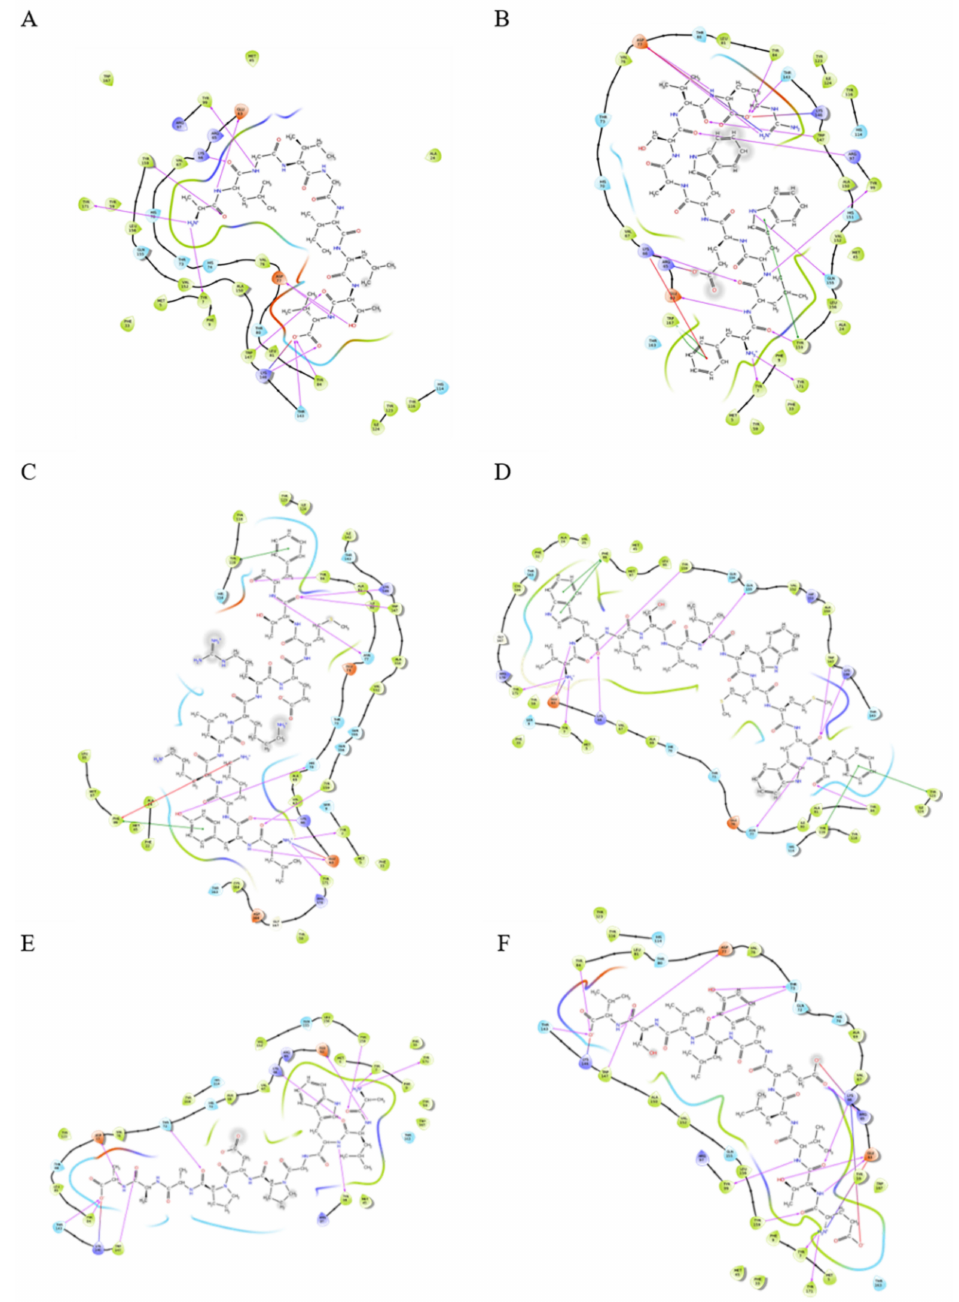
Figure 2. A 2D structure of the interaction between peptide and HLA structure. Residues are represented by the shape of water droplets. The interactions between residues and ligands are represented by lines and colored according to different interaction types. The hydrogen bond is colored in magenta and the Pi-Pi bond is colored in green. Magenta gradient lines represent salt bridge. ( A ) Interaction of HLA-A * 02:01 (PDB ID: 1JHT) and its peptide (ALGIGILTV). Hydrogen bonds are formed between peptide and amino acids TYR7, GLU63, LYS66, ASP77, TYR84, TYR99, THR143, LYS146, TRP147, TYR159 and TYR171. A salt bridge is formed with residue LYS146. ( B ) Interaction of HLA-A * 02:01 (PDB ID: 1JHT) and HBV-positive peptide (FLWEWASVR). Hydrogen bonds are formed between peptide and amino acids TYR7, GLU63, LYS66, ASP77, TYR84, ARG97, TYR99, THR143, TRP147, GLU155, TYR159 and TYR171, Pi-Pi bond is formed with residue TYR159 and salt bridges are formed with residue ARG65, ASP77 and LYS146. ( C ) Interaction of HLA-A *